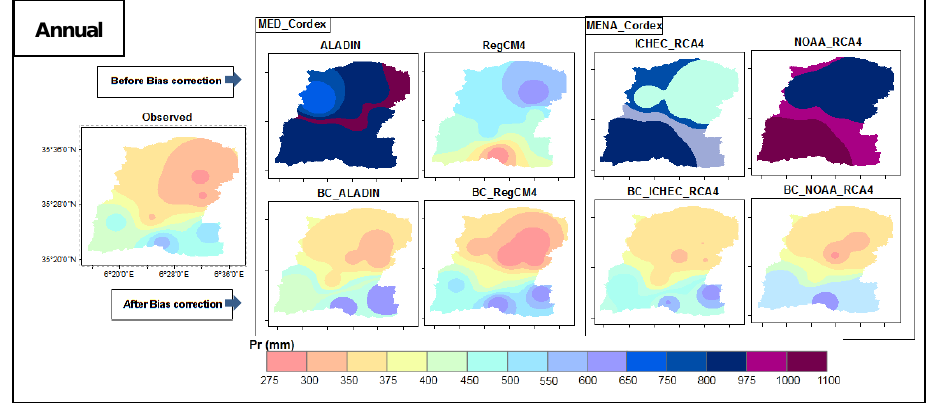
Figure 7. The spatial distribution of averaged annual precipitation for observed, raw, and adjusted (BC) RCMs for the period (1970 – 2005) in the study area.